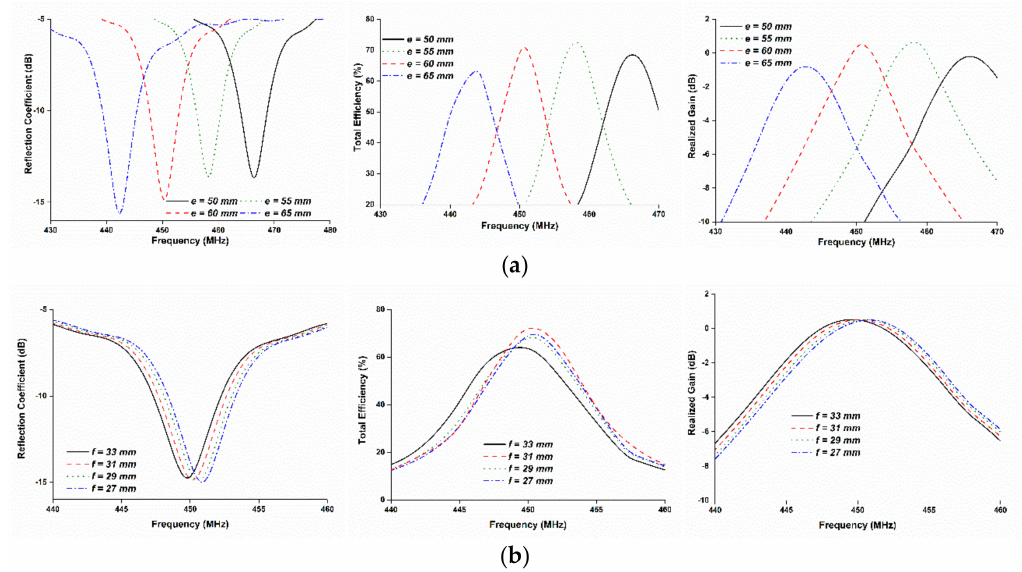
Figure 3. ( a ) Parametric study on the length of e and ( b ) parametric study on the length of the f : the radiating element e has a strong influence on the resonant frequency rather than f .